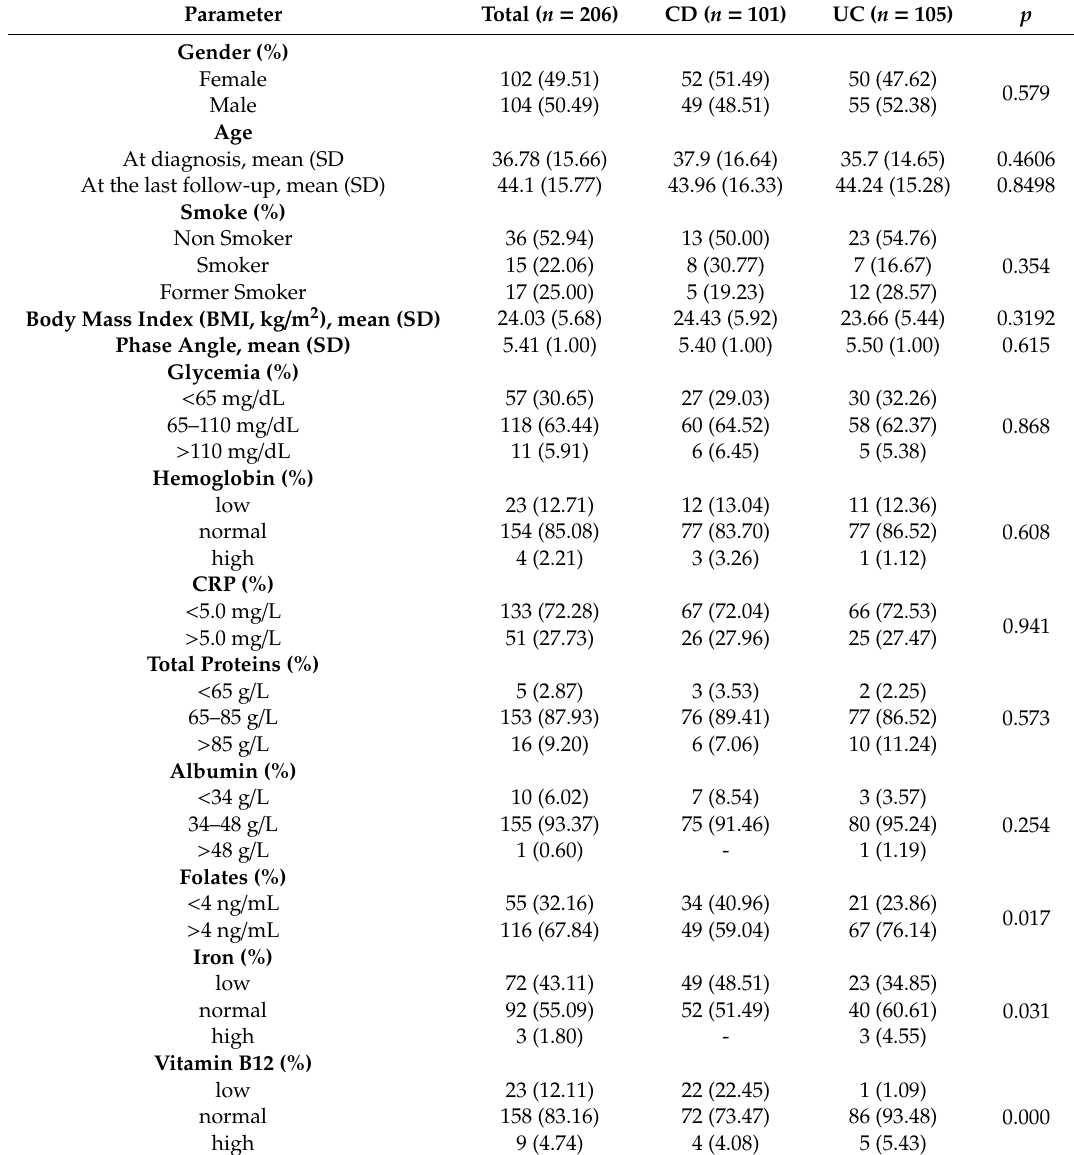
Table 2. characteristics. Results displayed as the number of patients (percentage of the total number of patients for which a given parameters was measured). Body mass index (BMI) and phase angle are displayed as mean (standard deviation). Some of the parameters listed in the table were measured in a subset of the total number of